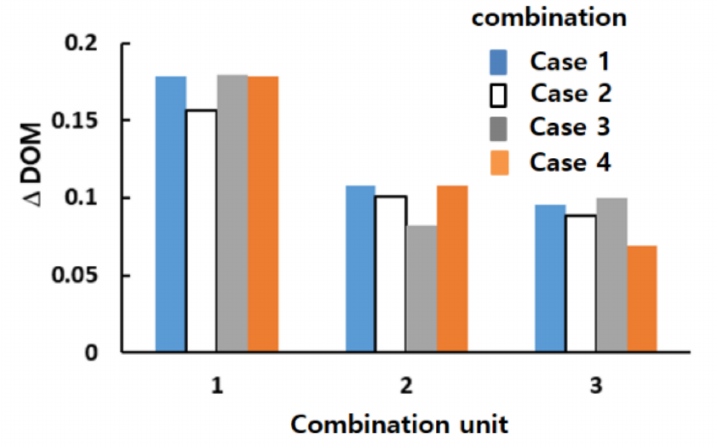
Figure 18. Comparison of the DOM increment in each combination unit for Re =